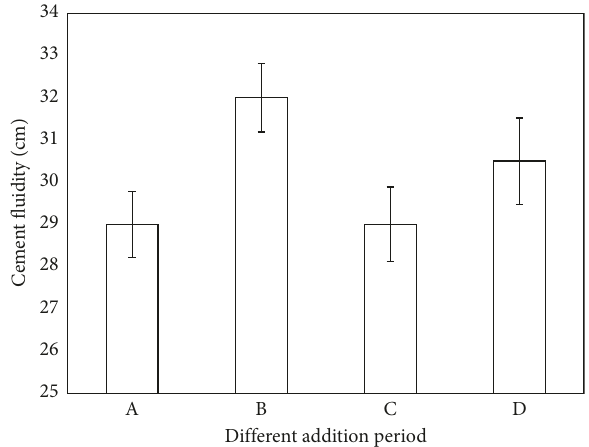
Figure 1: Effect of different addition periods of wheat straw (WS)